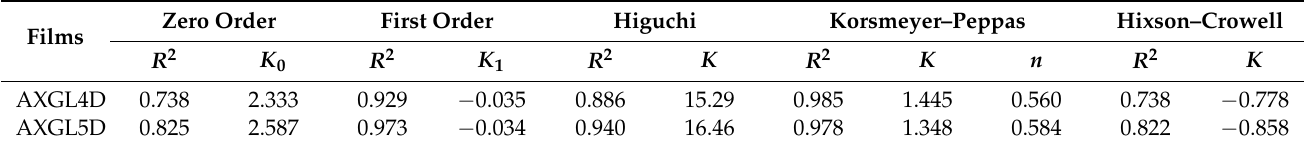
Table 3. Mathematical modeling of antibiotic release from AX-GL films.